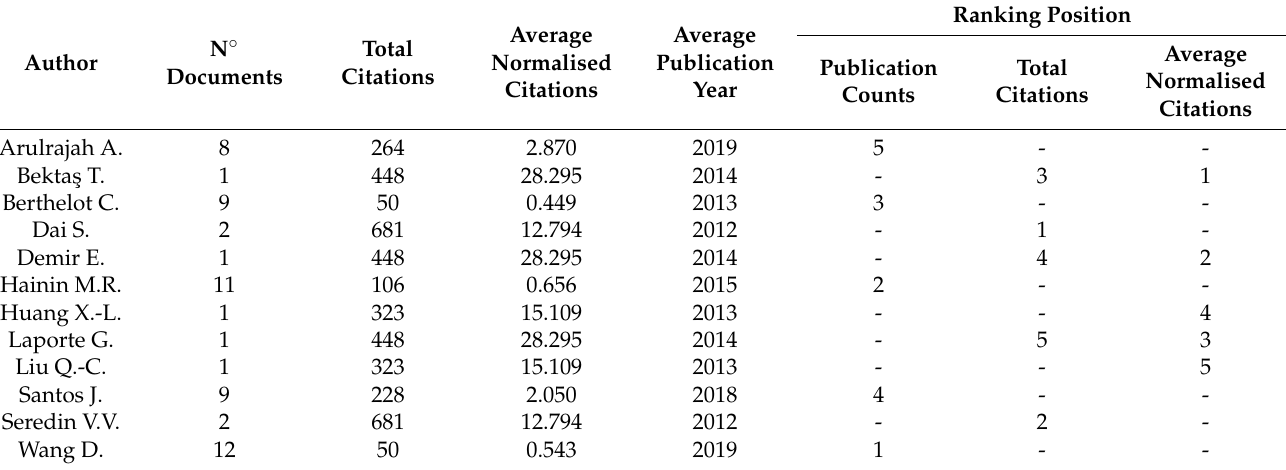
Figure 4. Network relationship of sources in terms of total citations. Table 3. Main authors in terms of publication count, total citations, and average normalised cita- tions.